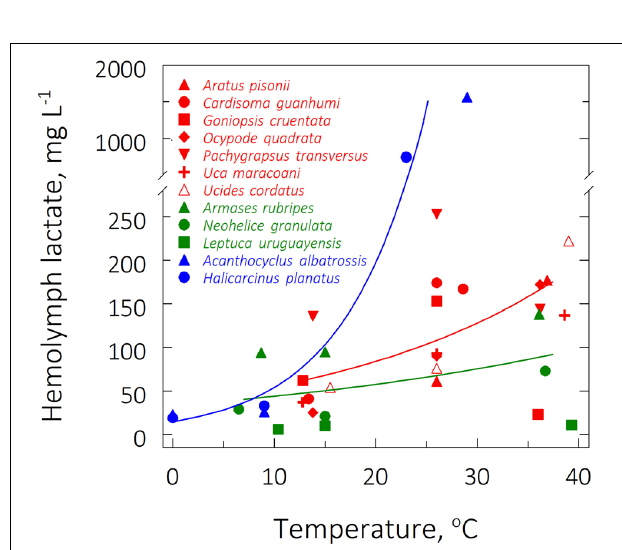
FIGURE 3 | Effect of direct transfer of tropical (red), subtropical (green) and sub-Antarctic (blue) crab species on hemolymph lactate concentration after 6 h exposure to their respective upper and lower critical thermal limits, from their corresponding field reference temperatures of 26, 15, and 9 ◦ C. Data (mg L − 1 ) are mean values (4 ≤ N ≤ 7), and were adjusted to a second degree polynomial curve.